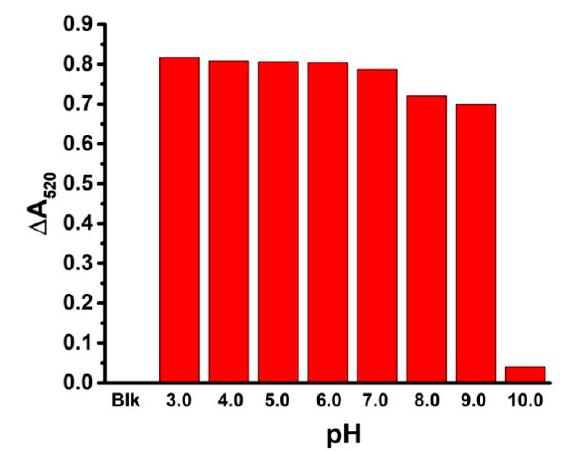
Figure 6. The pH effect on the assay for ethoprophos (10.0 µ M) based on the measurement of ∆ A 520 of RB-AuNPs.